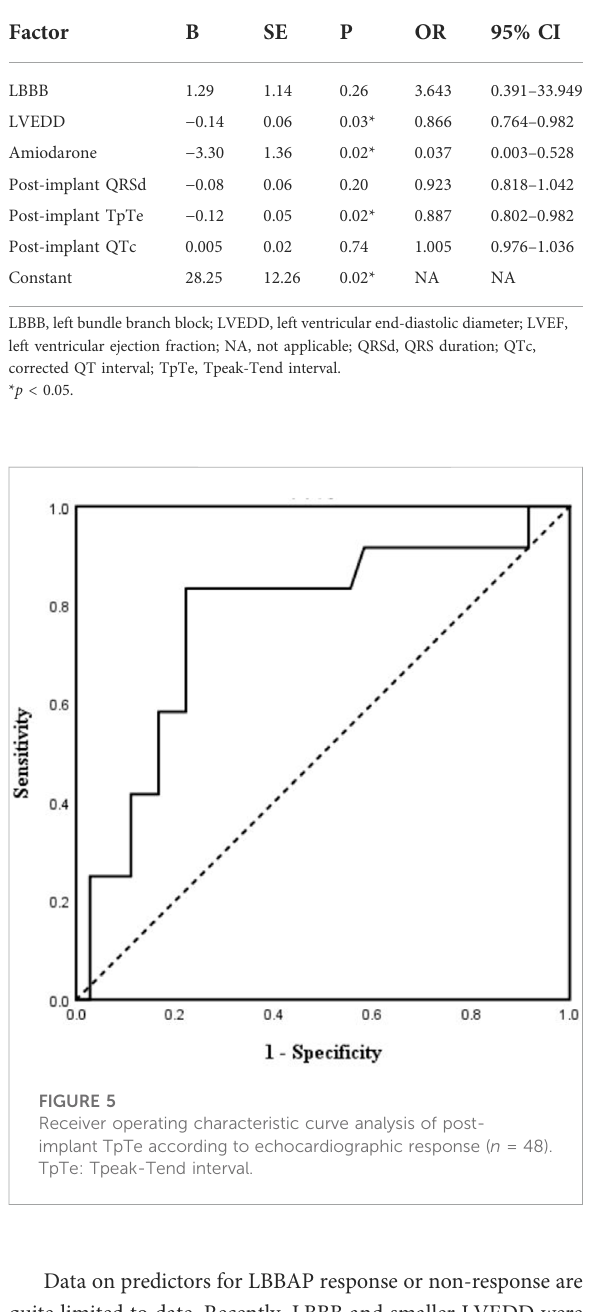
TABLE 5 Multivariable logistic regression analysis of factors associated withechocardiographic responseamong patients with QRS > 130 ms ( n = 48).